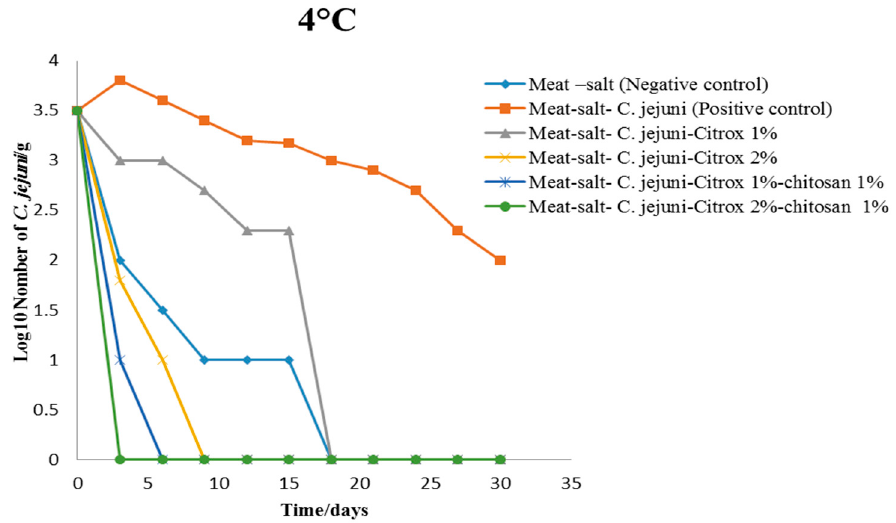
The TVCs of C. jejuni in camel meat during 30 days of storage at 4 °C are presented